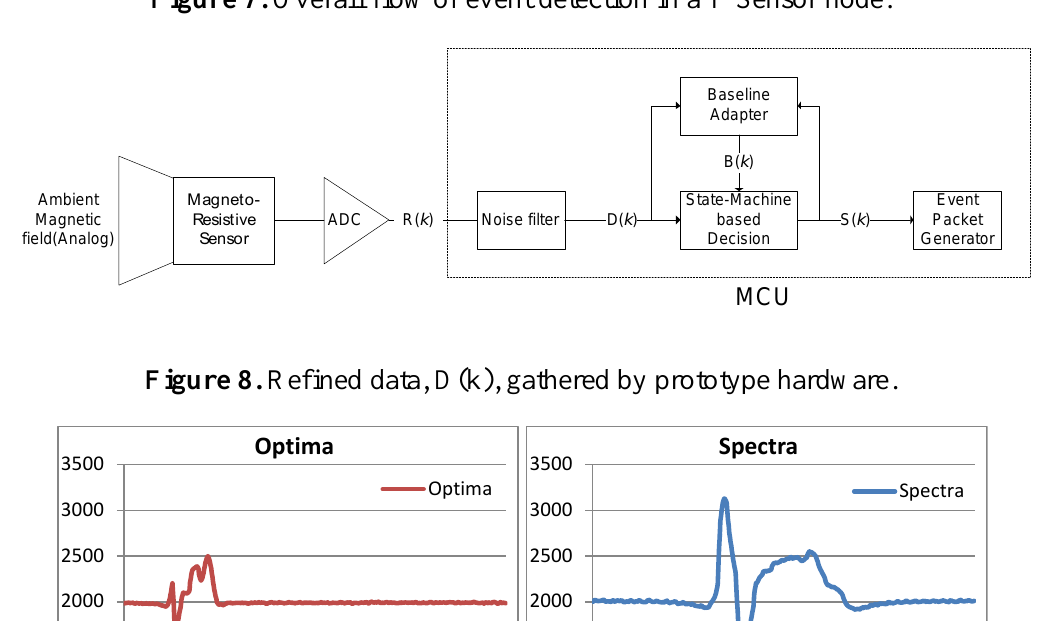
Figure 7. Overall flow of event detection in a T-Sensor node.